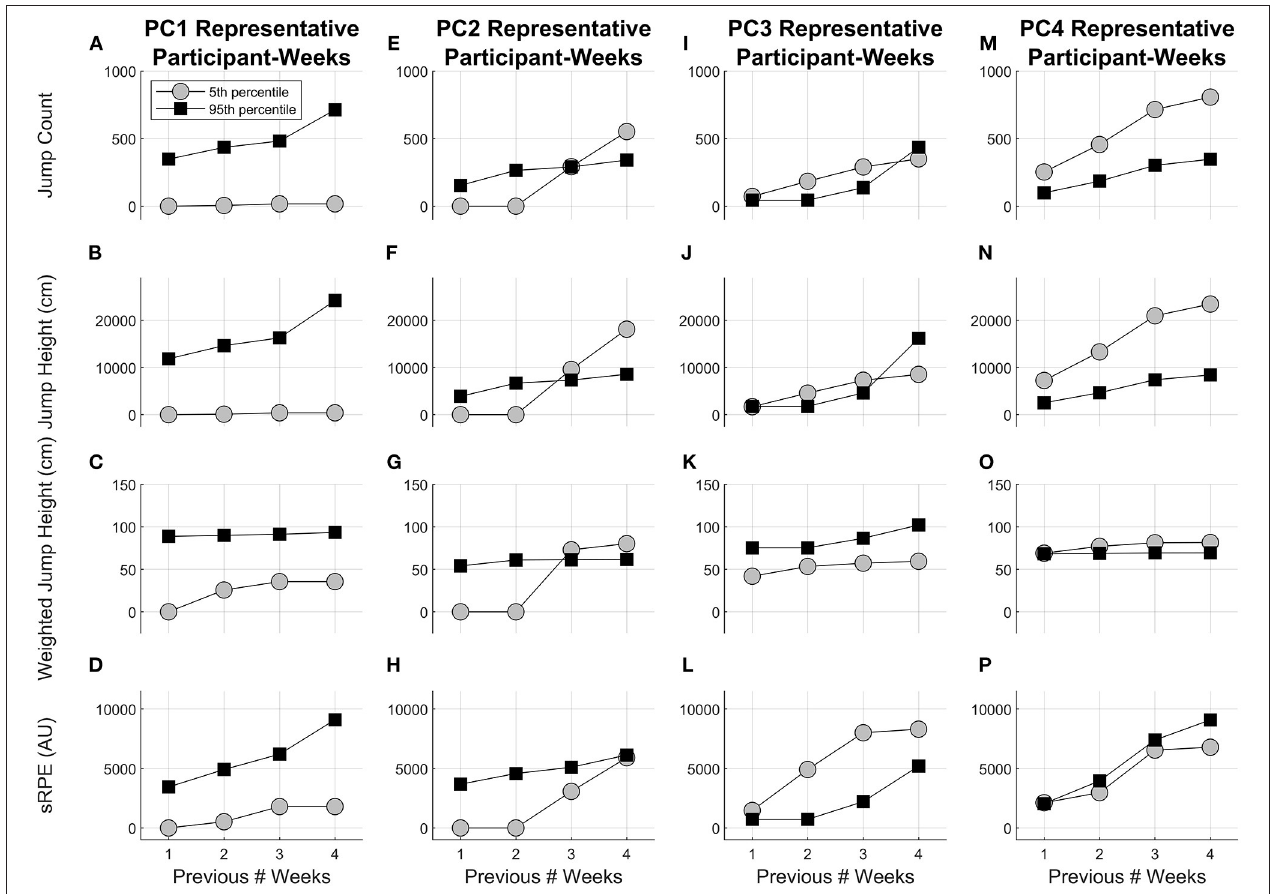
FIGURE 8 | Original workload variables for the 5th and 95th percentile representative participant-weeks for (A–D) PC1, (E–H) PC2, (I–L) PC3, and (M–P) PC4. Fifth percentile represents a low PC score, and 95th percentile represents a high PC score for a given PC. Note that the representative participant-weeks are different for each